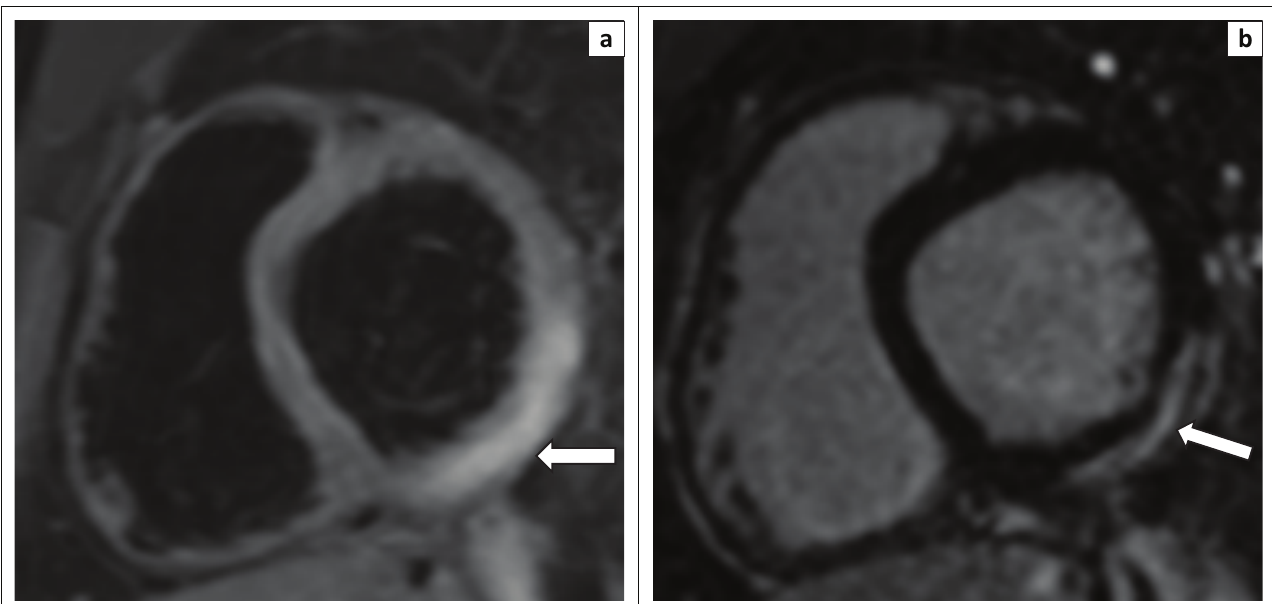
FIGURE 9: Myocarditis. T2W short-axis image (left) demonstrates LV inferolateral wall high signal and oedema (arrow). The equivalent late gadolinium image (right) demonstrates epicardial enhancement in the same region